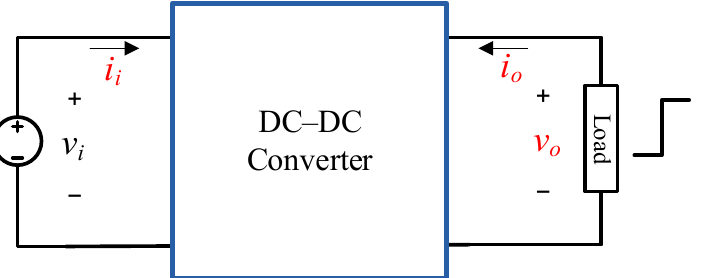
Figure 4. Load current step change-based measurement setup for output impedance and back current gain.